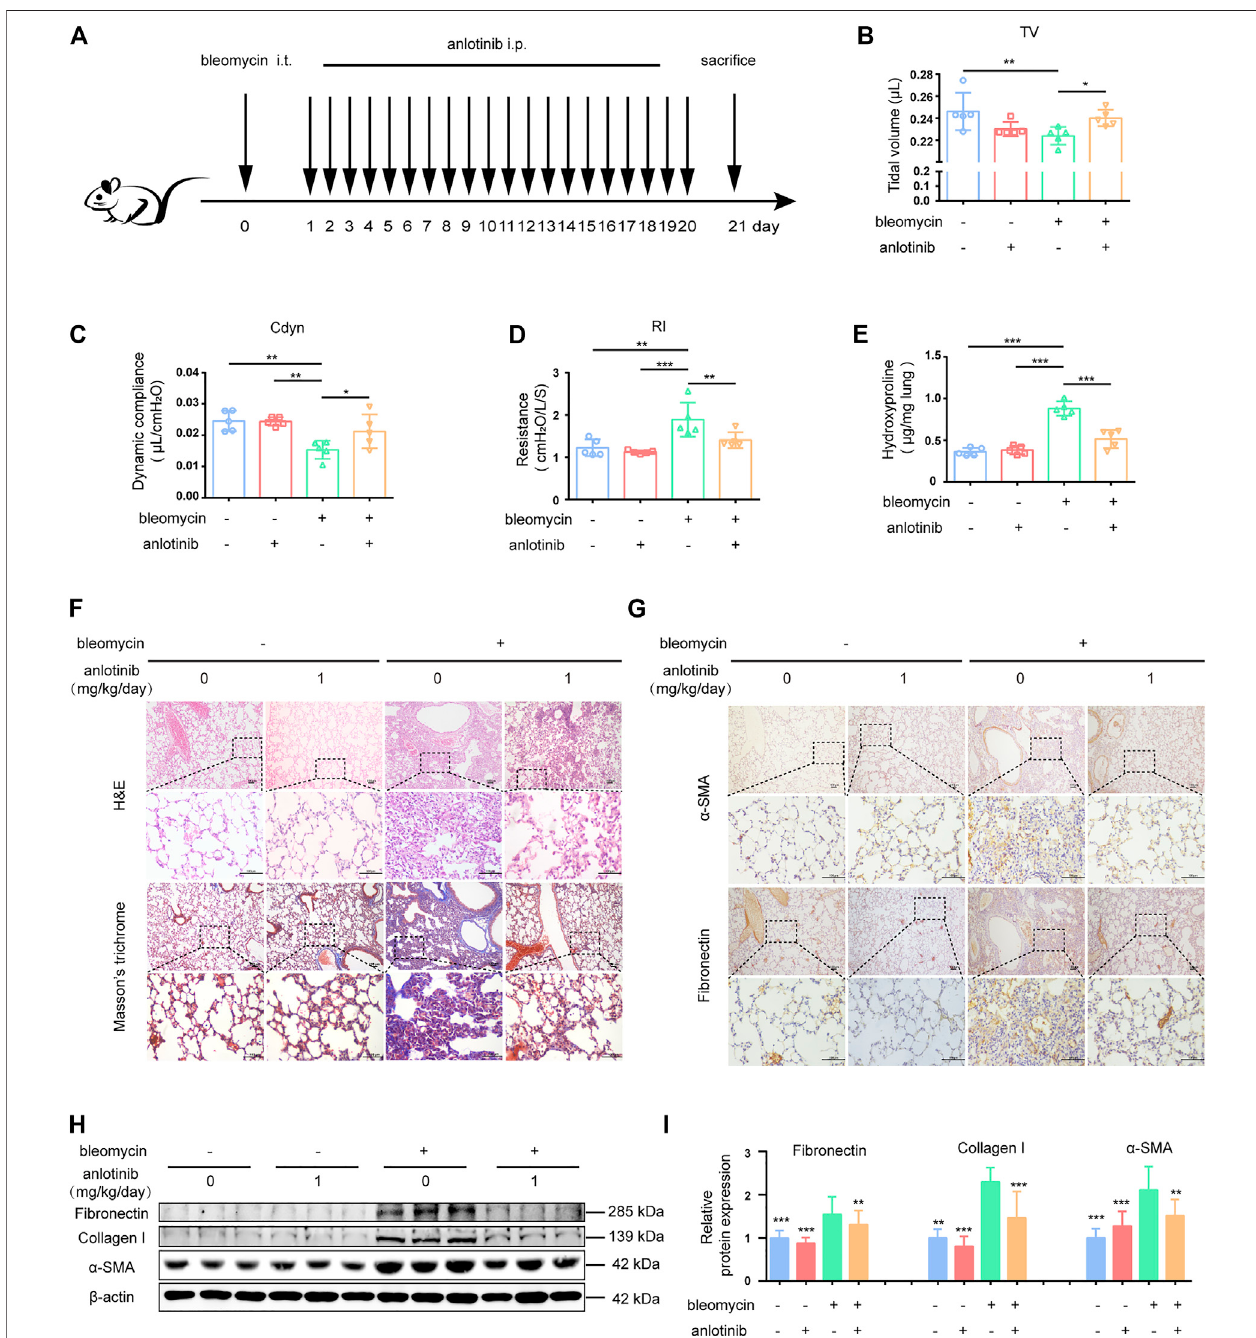
FIGURE 5 | Anlotinib attenuates bleomycin-induced pulmonary fi brosis. (A) Intervention dosing regimen of anlotinib in experimental mouse model of fi brosis. C57BL/6 mice were intraperitonealy injuected with 1 mg/kg of anlotinib or vehicle (n (cid:1) 5-6 per group) daily after bleomycin instillation. Lungs were harvested at 21 days for the following analyses. Analysis of tidal volume (TV) (B) , dynamic compliance (Cdyn) (C) , and lung resistance (RI) (D) (mean ± SD, n (cid:1) 5). (E) Hydroxyproline (HYP) contentsinlungtissuesfrommice(mean ± SD,n (cid:1) 5).Representativeimagesshowhaematoxylinandeosin(H&E),Masson ’ strichrome (F) , α -SMAandFibronectin staining (G) oflungsectionsfromtheindicatedgroupsofmice.Scalebars,100 µm. (H) WesternblotanalysisofFibronectin 、 CollagenIand α -SMA, β -actinwasusedas aloadingcontrol. (I) Quanti fi cationofFibronectin 、 CollagenIand α -SMAprotein levels relativeto β -actinisshown(mean ± SD, n (cid:1) 6). * p < 0.05,** p < 0.01,*** p < 0.001 VS BLM-treated group by one-way